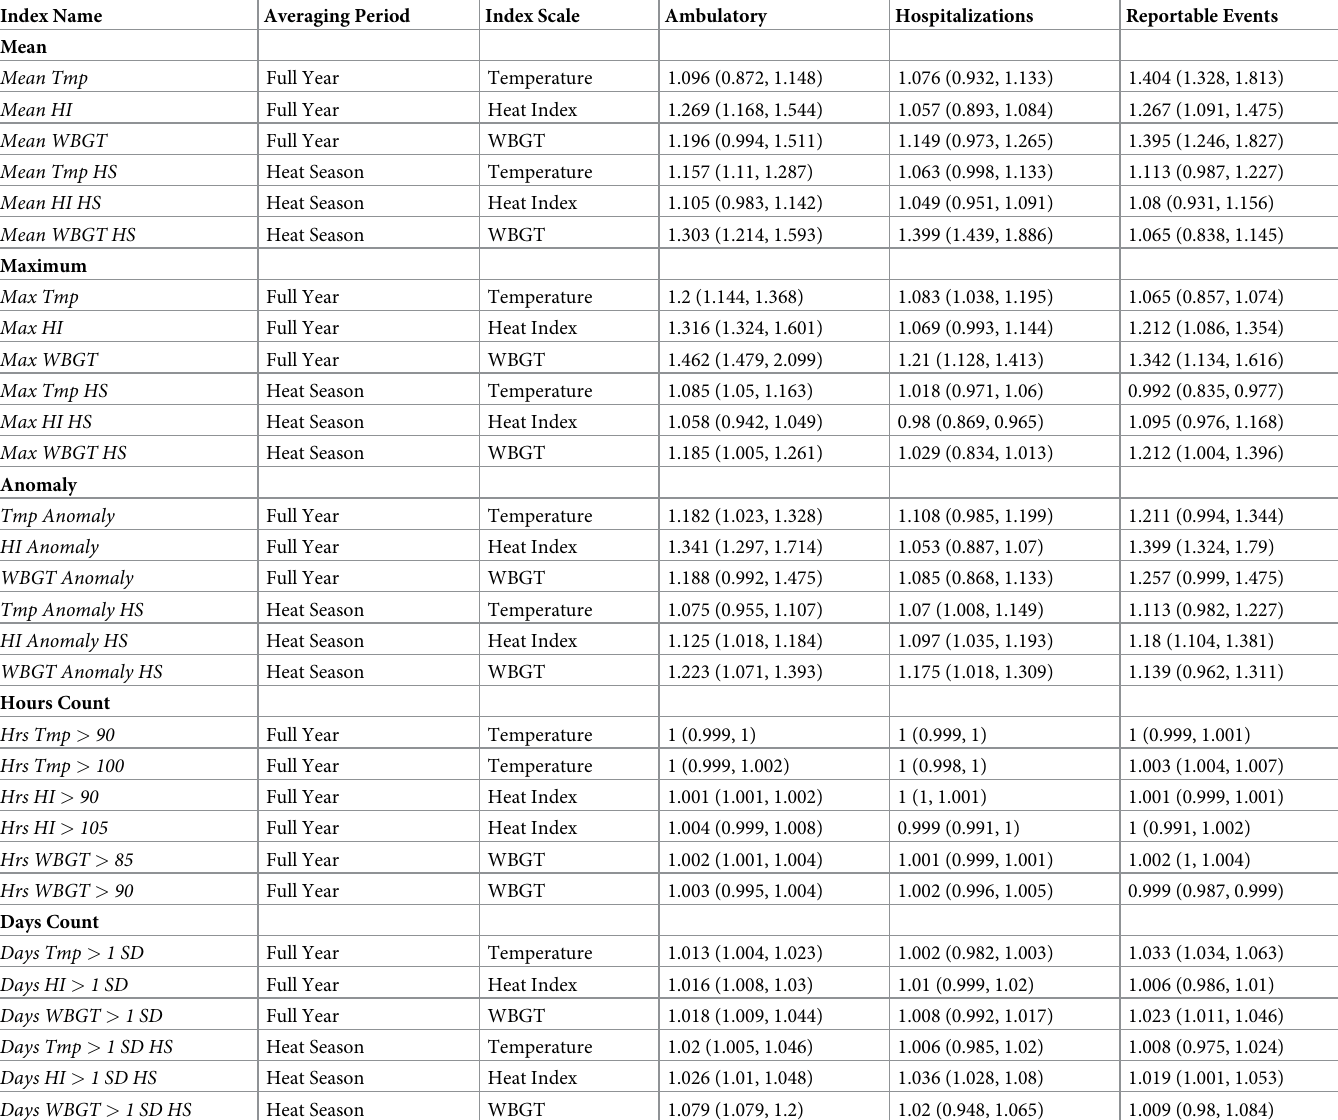
Table 4. Annual scale index-HSI outcome rate ratio 95% confidence interval from 2-year block bootstrap negative binomial